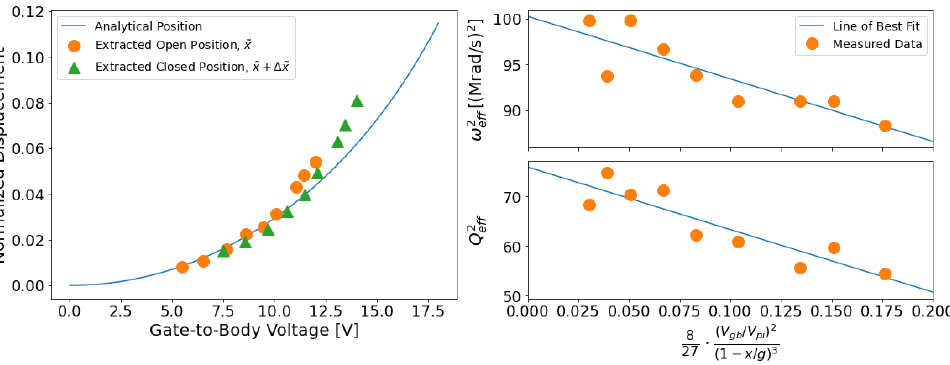
Figure 5. ( left ) A plot of the extracted position before and after closing for a given Gate-to-Body voltage. The incremental displacement, ∆ x , was found by integrating the velocity curves and used with V gb in the open and closed positions to solve a system of equations for x open and V pi . ( right ) Measurements of Q ef f and ω ef f used to extract ω 0 and Q 0 from collected data using a linear fit. The true natural frequency and true damping ratio are the y-intercepts of the linear